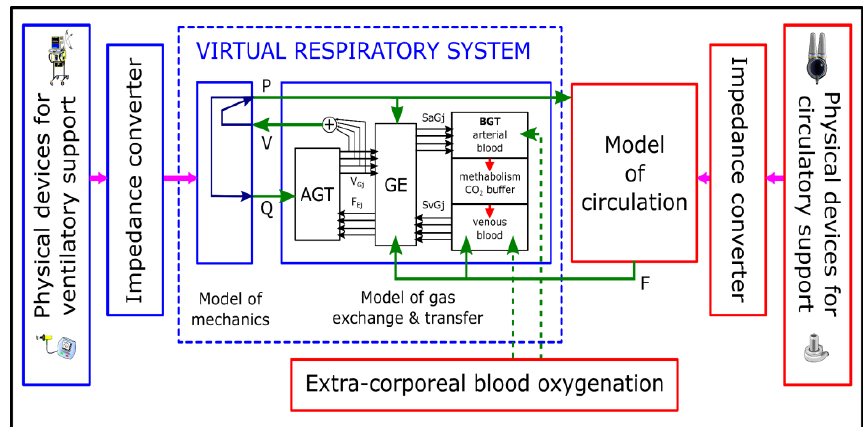
Figure 1. The idea of the cardiopulmonary hybrid platform developed by the authors. As oxygen delivery and carbon dioxide removal are the fundamental goals of the cardiorespiratory system, the model of gas transfer and exchange is the central point (it consists of modules of AGT — airways gas transfer, GE — gas exchange, BGT — blood gas transport). Respiratory system mechanics influences AGT, GE, and circulation. Cardiovascular system mechanics influences BGT and GE. Respiration and circulation support as well as oxygenation/decarbonation can be simulated or realized with physical devices by means of impedance converters playing the role of numerical – physical interfaces. V, Q, P and F denote volumes, airflows and pressures in the respiratory system, and blood flows, respectively.